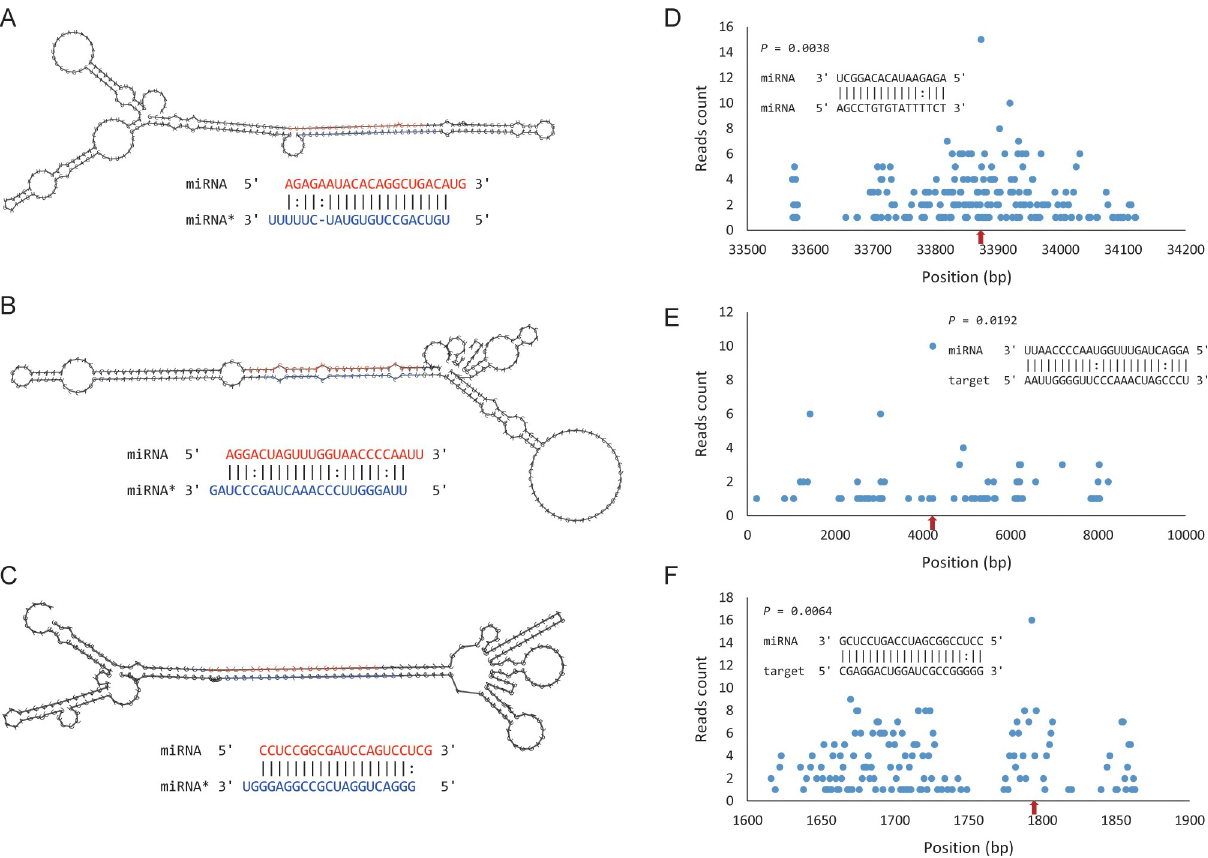
Fig 2. The second structure and target sequence of predicted novel miRNAs. The stem-loop structure and miRNA-miRNA � duplex of Novel_2_38 (A), Novel_10_88 (B) and Novel_10_147 (C). The target sequence and cleavage read count by degradome sequencing of Novel_2_38-GRMZM2G308707 (D), Novel_10_88-AC190628.4_FG007 (E) and Novel_10_147-GRMZM2G064212 (F).